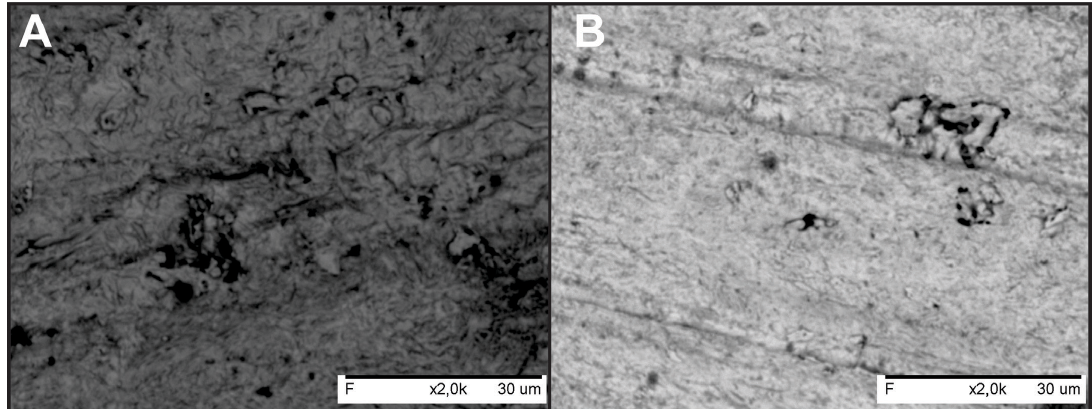
SO in the absence (A) and presence of 250 mg·L -1 of methanolic 2 4